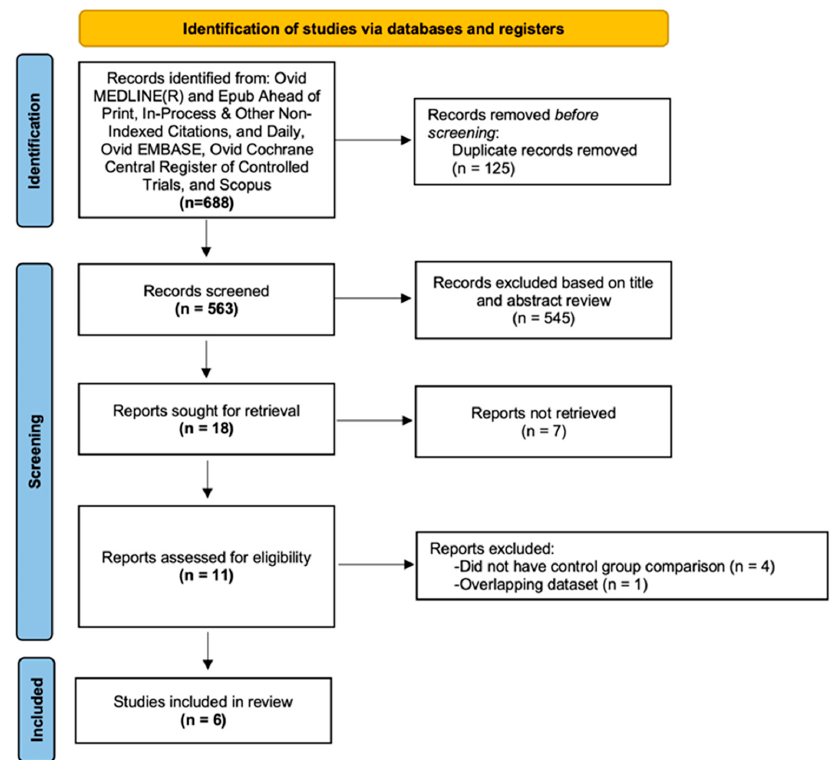
Figure 1. Study selection.